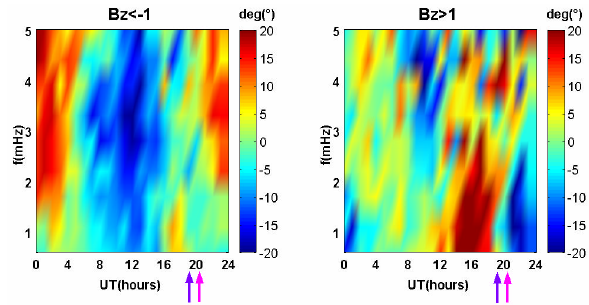
Fig. 5. Daily distribution of the average phase difference between the two stations for Bz< − 1nT and Bz> 1nT. Pink and violet ar- rows indicate local geomagnetic noon at TNB and SBA, respec-